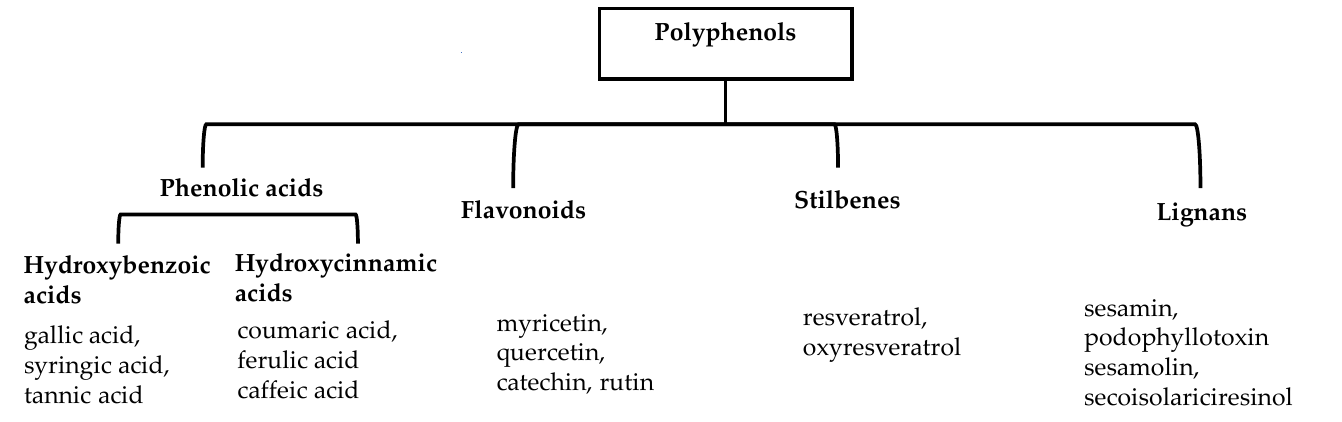
Figure 1. Schematic presentation of classification of polyphenols.